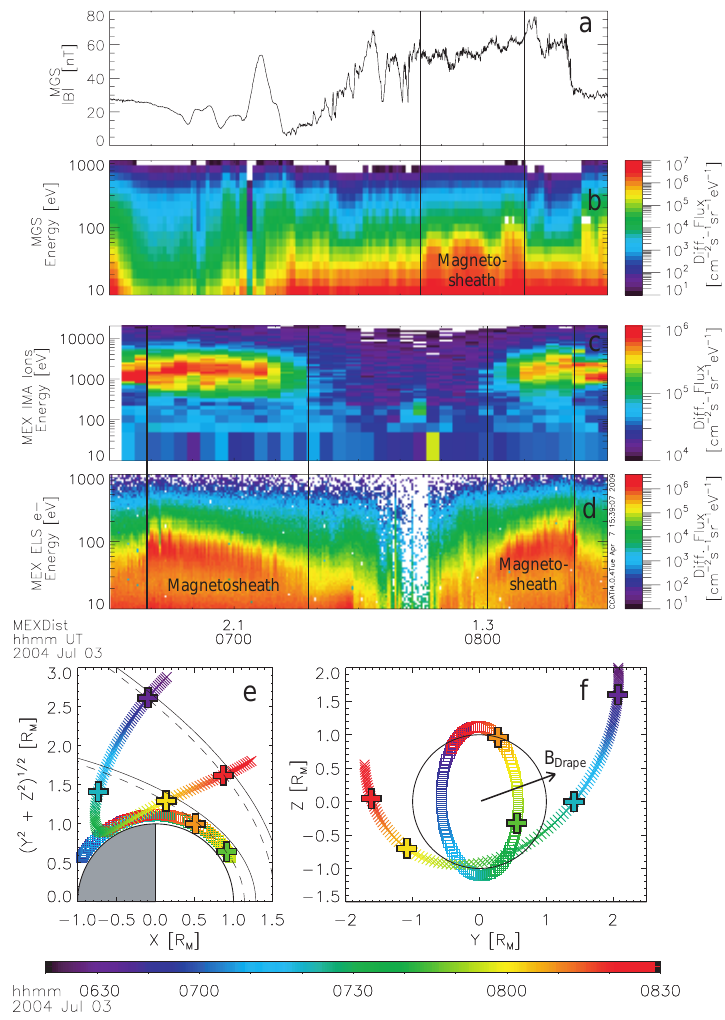
Fig. 3. MGS and MEX data for Case 1: time series of (a) MGS/MAG magnetic field strength, (b) MGS/ER omni-directional electron spectrogram, (c) MEX/IMA omni-directional ion spectrogram, (d) MEX/ELS omni-directional electron spectrogram and the orbits of MGS (squares) and MEX (crosses) in (e) cylindrical MSO coordinates and in (f) the MSO y-z-plane, colour coded by time. The black vertical lines in panels (a-d) indicate when MGS or MEX crosses the BS and MPB. The positions of those crossings are shown as large plus signs in panels (e) and (f). The black solid lines in panel (e) show the average location of BS and MPB (Vignes et al., 2000) and the black arrow indicate the direction of the magnetic field draping from MGS measurements. The black dashed lines indicate possible shapes of the BS and MPB based on the observed crossings in this